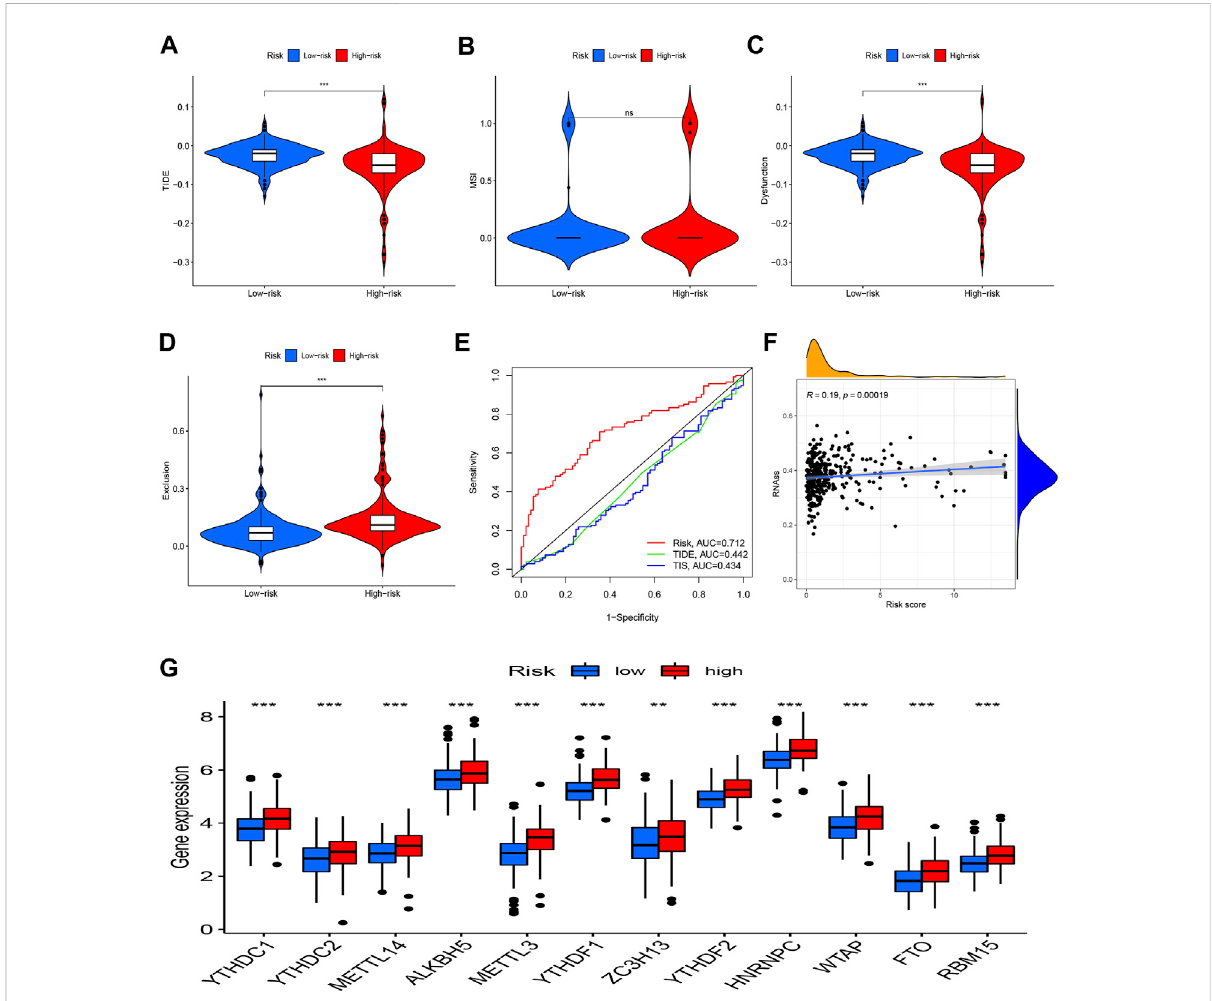
TIDE, m6A-related genes, and tumor stemness. (A) TIDE score between two groups; (B) MSI score between two groups; (C) Dysfunction score betweentwogroups; (D) Exclusionscorebetweentwogroups; (E) ROCanalysisofriskmodel,TIDEandTIS; (F) CorrelationanalysisbetweentheRNA stemness and the risk model; (G) Expression of m6A-related genes in risk groups. * p < 0.05, ** p < 0.01, *** p <